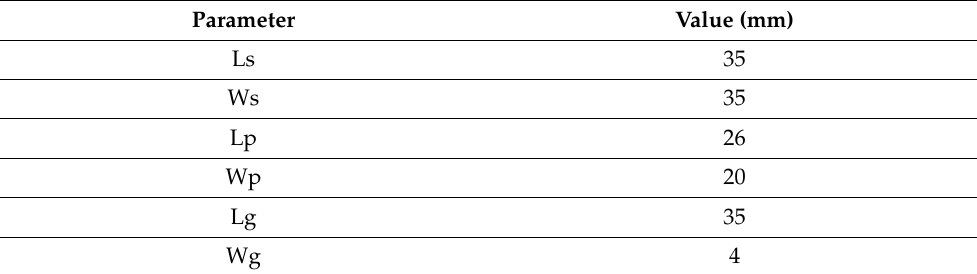
Figure 3. ( a ) Conventional microstrip patch antenna versus ( b ) the proposed patch antenna. Antenna dimensions were optimized, as shown in Table 2, according to the theoretical design rules mentioned before. Table 2. Optimized dimensions of the simulated patch antenna parameters.